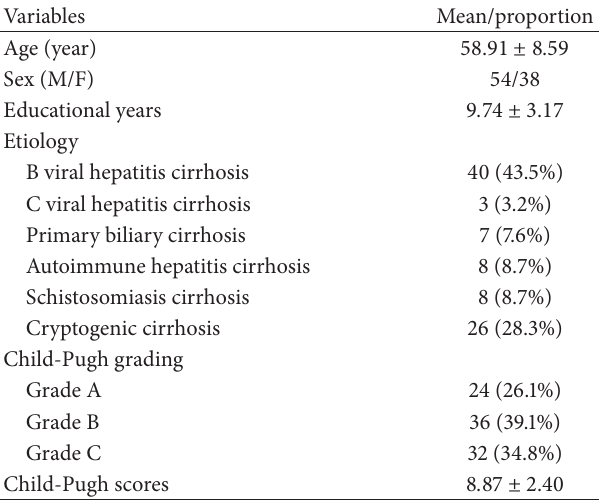
Table 1: Cirrhotic patient